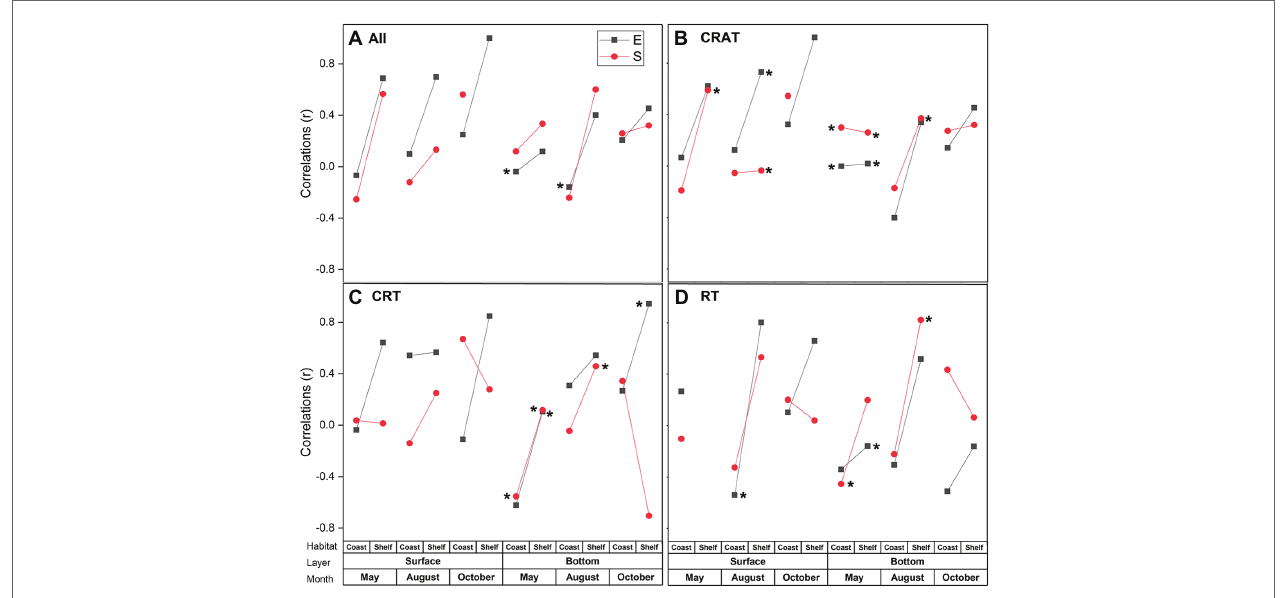
FIGURE 6 | Mantel tests for the correlations among environmental distance (E), spatial distance (S), and protist communities’ distance ( A . All; B . CRAT; C . CRT; and D . RT) in surface and bottom layers in coastal and shelf areas in each season using Spearman’s rank coefficients. Asterisks besides the dot indicate significant correlations ( p <